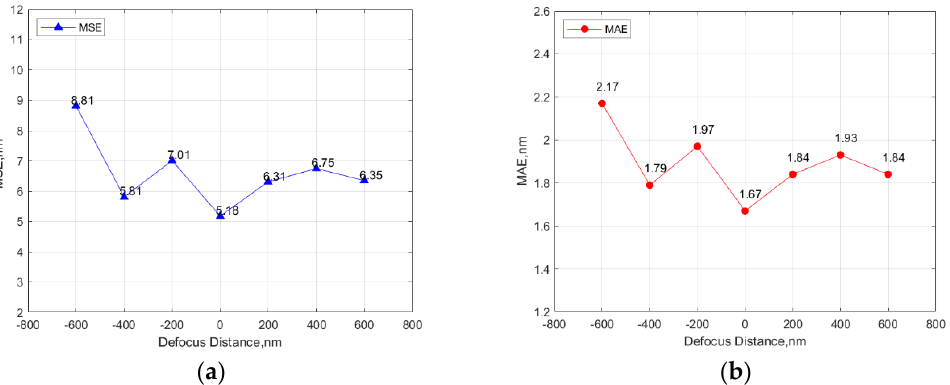
Figure 15. The MSE and MAE of Focus & TSOM-CNN testing by different defocus instance images. ( a ) MSE and ( b ) MAE.